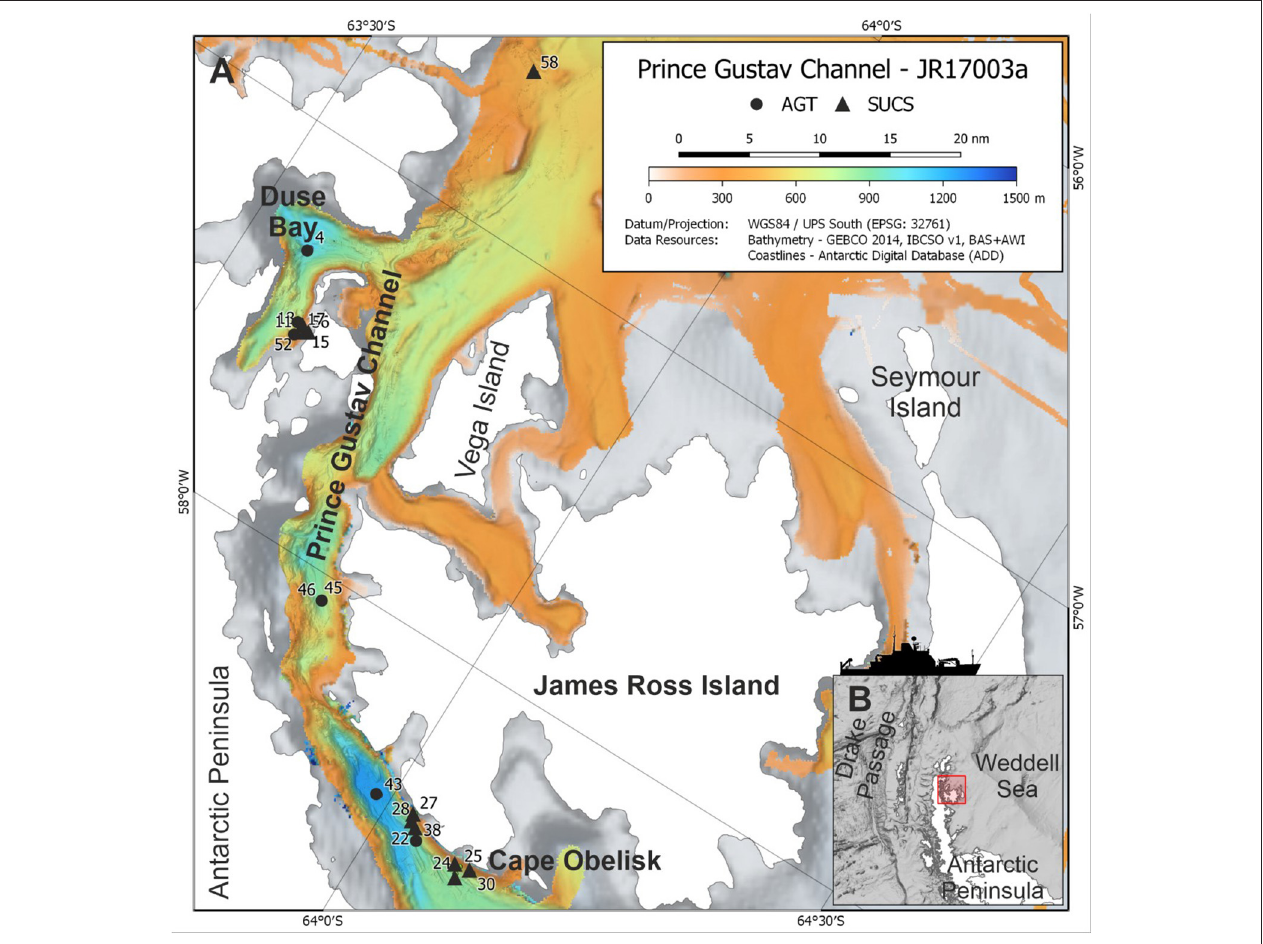
FIGURE 1 | Map of study area. (A) Station locations of SUCS and AGT deployments during JR17003a, including event deployment numbers. (B) Position of the Prince Gustav Channel on the Antarctic Peninsula in the Southern Ocean. Bathymetry data archived from Dreutter et al. (2020).